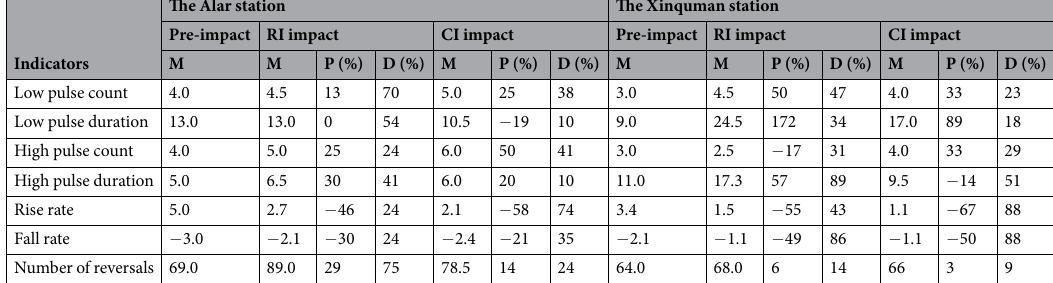
Table 3. Comparison of hydraulic alterations for indicators in Groups 4 and 5 at the two stations for the pre- impact, RI impact and CI